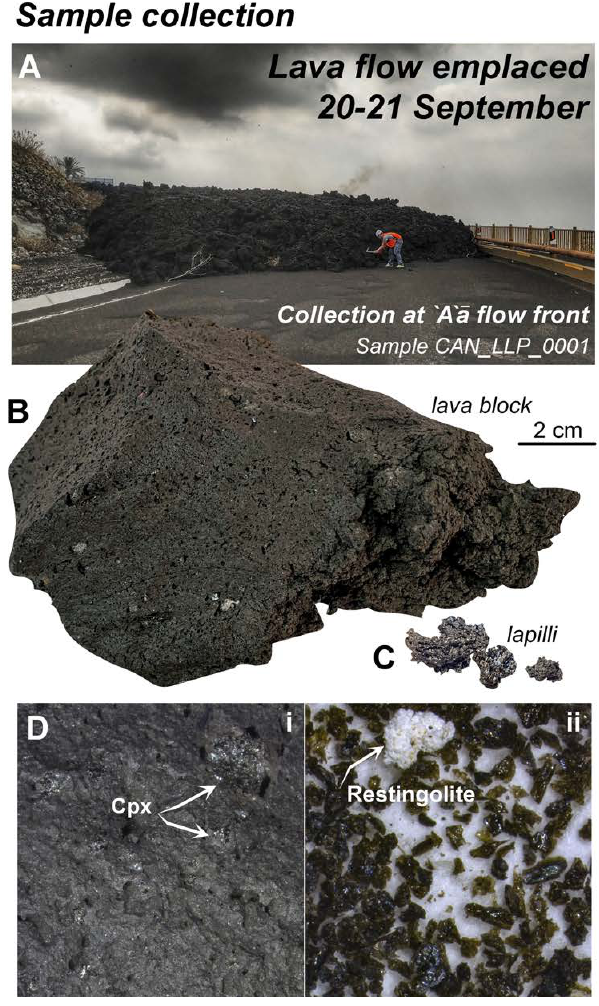
Figure 2: Field photograph and hand specimens: [A] CAN_LLP_0001 lava collection at flow front [B] CAN_LLP_0001 hand specimen; [C] CAN_TLP_0001 coarse particles hand specimen; [D] (i) CAN_LLP_0001 stereomicroscope image, (ii) CAN_TLP_0011 stereomi- croscope image including ultra-rare restingolite (pend- ing